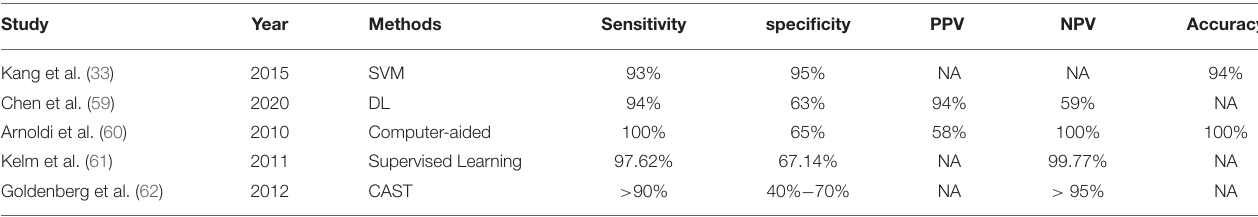
TABLE 5 | The diagnostic performance of artificial intelligence in coronary